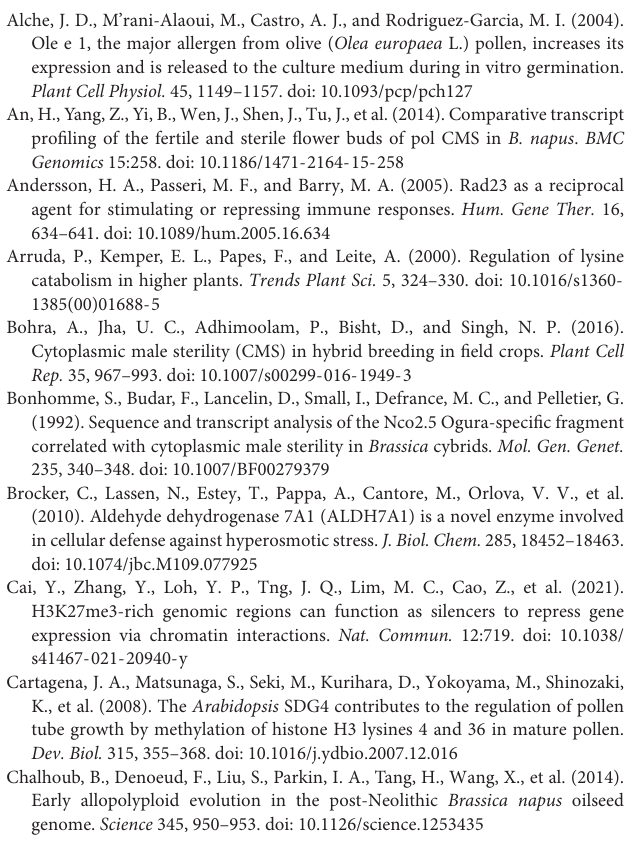
sequences; red line: PPR motif region.